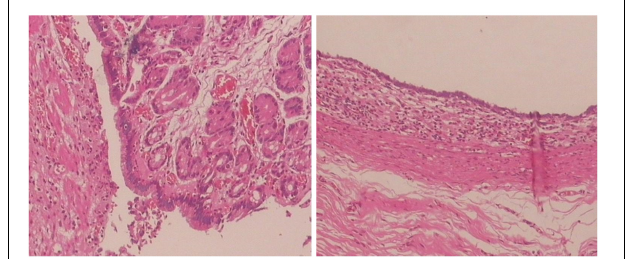
FIGURE 4 | Histopathology of the resected specimen showing the cystic lesion was lined with columnar epithelial mucosa and had its own smooth muscle layer. (Hematoxylin and eosin stain, ×